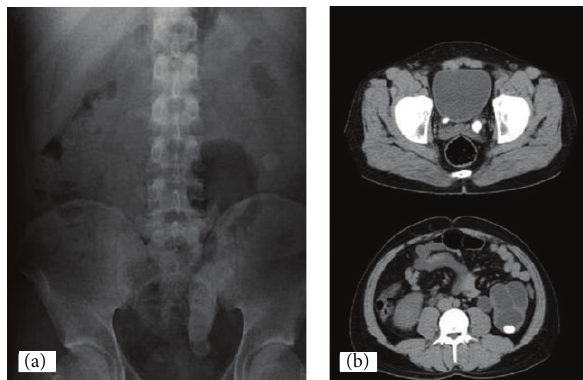
Figure 1: Plain film shows a long radiopaque density (11.5cm) suggesting a giant ureteral stone in the pelvic area (a). The CT scan of the abdomen shows a left giant ureteral stone measuring 11.5cm causing ureteral obstruction and other stones 2.5 cm in size in the lower pole of ipsilateral kidney and 7 mm in size in distal part of right ureter (b).